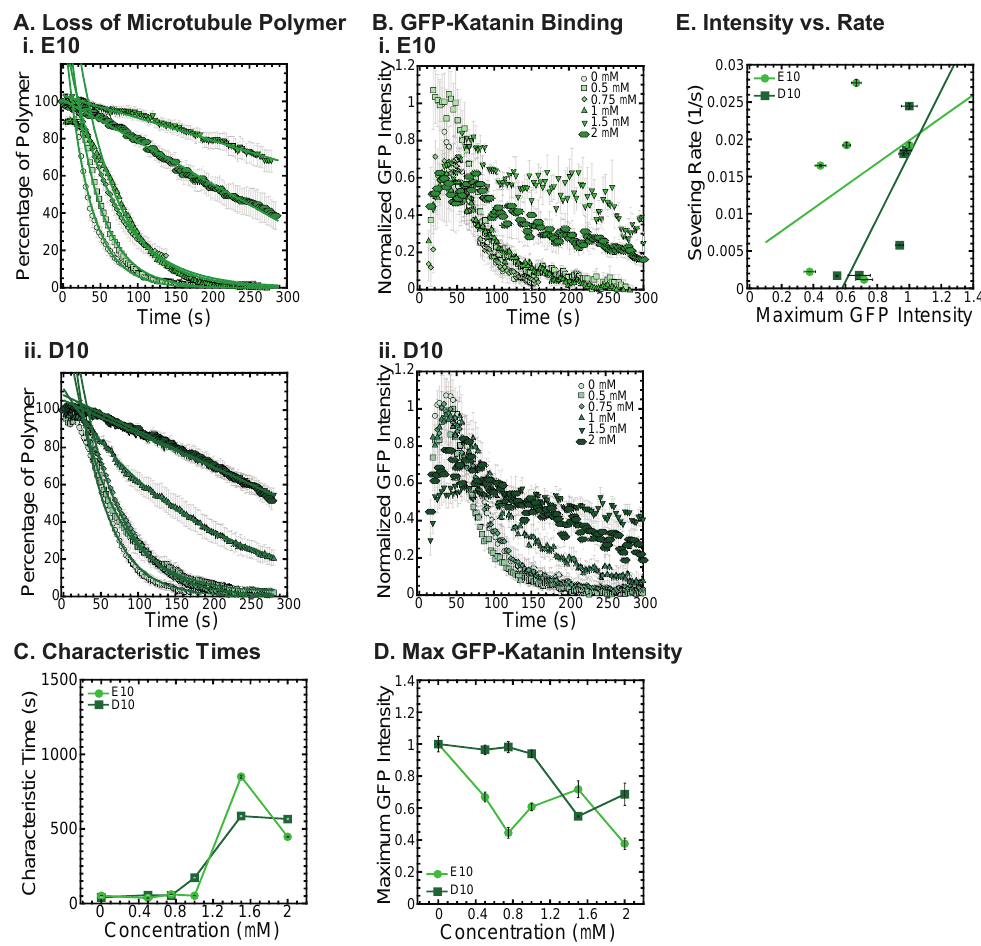
Figure 6. Katanin severing and binding inhibited by poly-E and poly-D peptides. ( A ) Loss of polymer caused by increasing concentration of ( i ) E10 peptides (light green) and ( ii ) D10 peptides (dark green). Datasets were fit to exponential decays because these CTTs did not inhibit severing significantly as the amount of inhibitor is changed from no inhibitor (0 μM, lightest shade circles), low inhibitor (0.5 μM, light shade squares; 0.75 μM, light shade diamonds), medium inhibitor (1 μM, medium shade triangles with point up), to highest inhibitor (1.5 μM, darker shade triangles with point down, 2 μM, darkest shade hexagons). The transition from exponential decay to linear decay is observed for loss of polymer data as it goes from no inhibitor (0 μM, lightest shade circles), low inhibitor (0.5 μM, light shade squares; 0.75 μM, light shade diamonds), medium inhibitor (1 μM, medium shade triangles with point up), to highest inhibitor (1.5 μM, darker shade triangles with point down, 2 μM, darkest shade hexagons). Each dataset is fit with a best fit equation to an exponential or linear decay with best fit parameters provided in Supplemental Information Table S10. ( B ) The data for the GFP-katanin binding by increasing concentration of ( i ) E10 peptides (light green) and ( ii ) D10 peptides (dark green). The data were normalized by the maximum when there was no inhibitor (0 μM, lightest shade circles). Data for low inhibitor (0.5 μM, light shade squares; 0.75 μM, light shade diamonds), medium inhibitor (1 μM, medium shade triangles with point up), to highest inhibitor (1.5 μM, darker shade triangles with point down, 2 μM, darkest shade hexagons) are shown. ( C ) The characteristic decay times for loss of polymer as a function of concentration for E10 peptides (light green circles) and D10 peptides (dark green squares). Error bars represent the uncertainty in the fit parameters. ( D ) The average normalized maximum for GFP-katanin binding to microtubules for E10 peptides (light green circles) and D10 peptides (dark green squares). Error bars represent the standard deviation of the average. ( E ) Plotting the rate of microtubule severing as a function of average normalized maximum intensity for E10 peptides (light green circles) and D10 peptides (dark green squares). No data displayed high GFP-katanin intensity due to a slow accumulation with little loss of polymer denoted by dashed line box (lower right). All data of the severing rate was fit to a linear function of GFP-katanin (see Supplemental Information Table S11). Representative movies in Supplemental Information Movies S12 and S13.